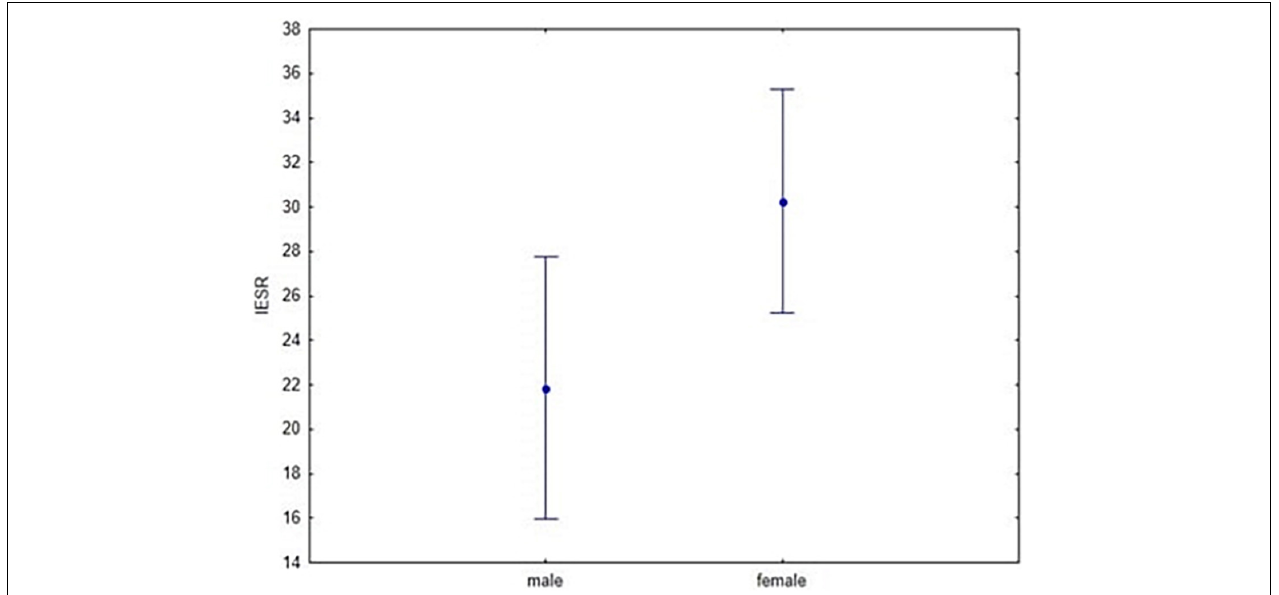
FIGURE 5 | Gender effect on IVAS score ( F = 6.5; p = 0.01). Vertical bars denote 0.95 confidence